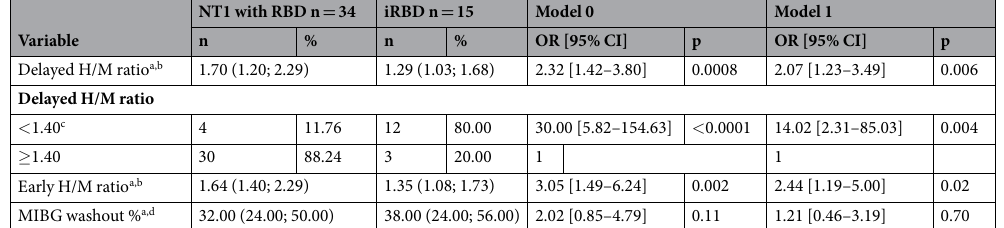
Table 2. Comparison of cardiac scintigraphy results in patients with narcolepsy type 1 (NT1) and rapid eye movement sleep behavior disorder (RBD) and in patients with idiopathic RBD (iRBD). a Continuous variables are expressed as median (minimal value; maximal value). b OR for 0.10-unit decrease. c Lowest tertile of the